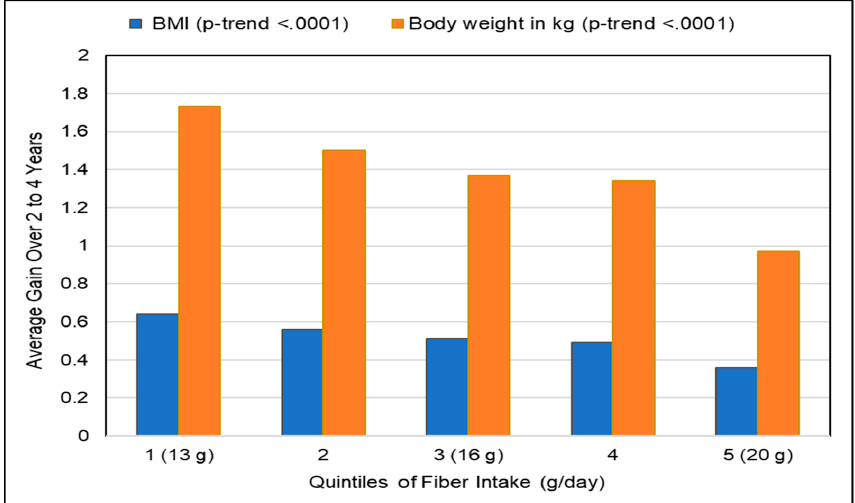
Figure 5. Change in body mass index (BMI) and weight associated with level of fiber intake from The Nurses’ Health Study (74,091 women; age 50 years; 12 years) [104].